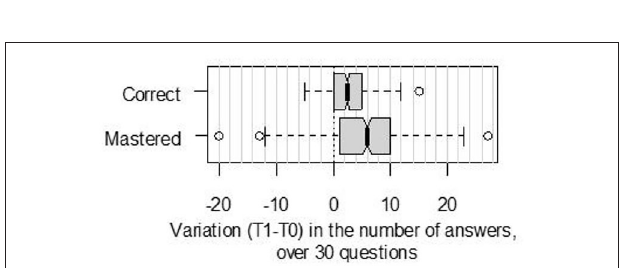
FIGURE 3 | Variation in the number of correct and mastered answers, between T0 and T1 (before/after reading the brochure), for n = 452 French parents who rated the correctness of 30 questions (true/false), and rated their degree of confidence for each answer (mastered = correct answer given with the maximal degree of confidence, on a 4-pt